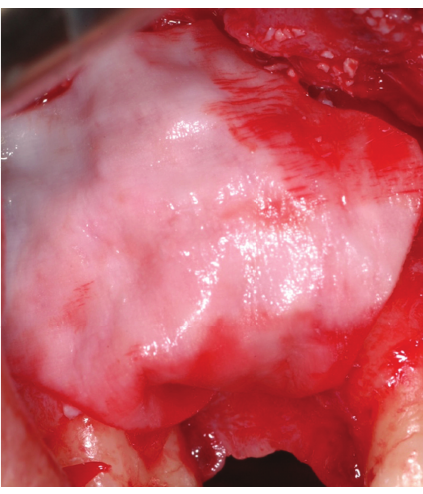
Figure 9: Resorbable collagen membrane laid over the graft to prevent soft tissue cells ingrowth.